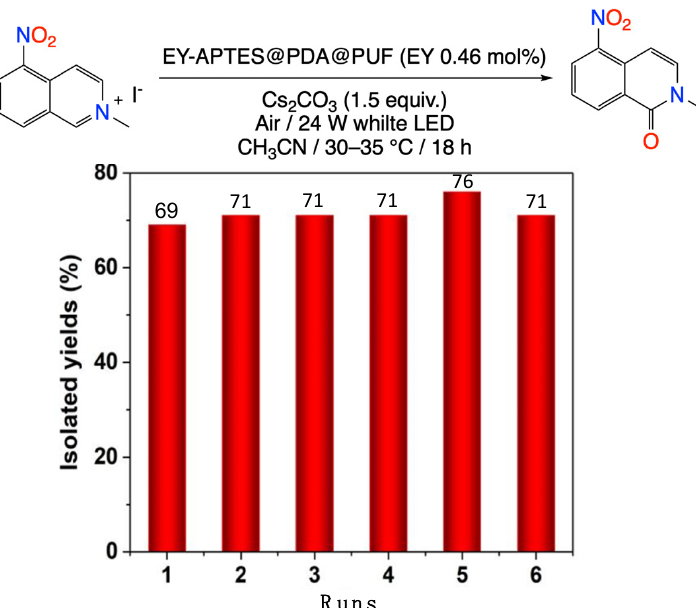
Figure 4. Isolated yields measured over the six successive runs of 2-methyl-5-nitro-isoquinolin-2-ium iodide oxidation photocatalyzed by a single sample of EY-APTES@PDA@PUF. Reaction conditions: 2-methyl-5-nitro-isoquinolin-2-ium iodide (0.2 mmol), Cs 2 CO 3 (0.3 mmol), EY-APTES@PDA@PUF